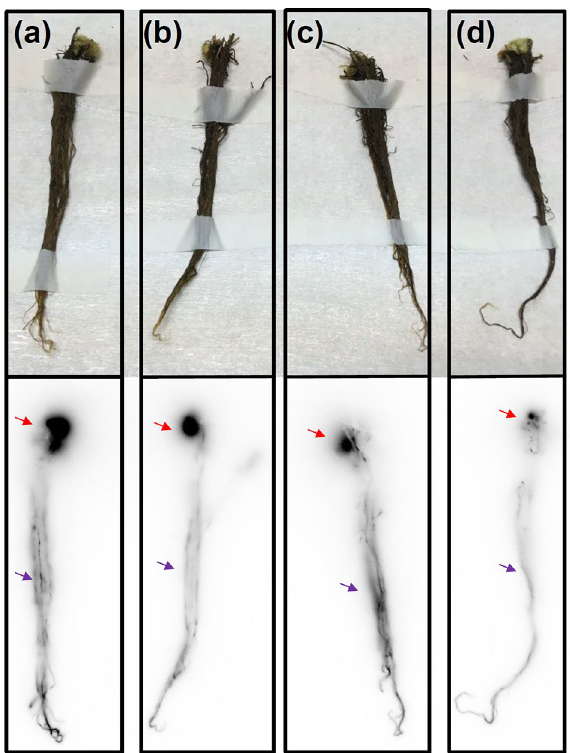
Figure 5. Autoradiography of static 74 As in rhizomes and roots of P . vittata exposed to As for 168 h. ( a ) Fed with 0.2 μM AsV . ( b ) Fed with 20 μM AsV. ( c ) Fed with 200 μM AsV. ( d ) Fed with 2000 μM AsV. All experiments included 2 kBq of 74 As-labeled AsV. Rhizomes (red arrow) and roots (purple arrow).